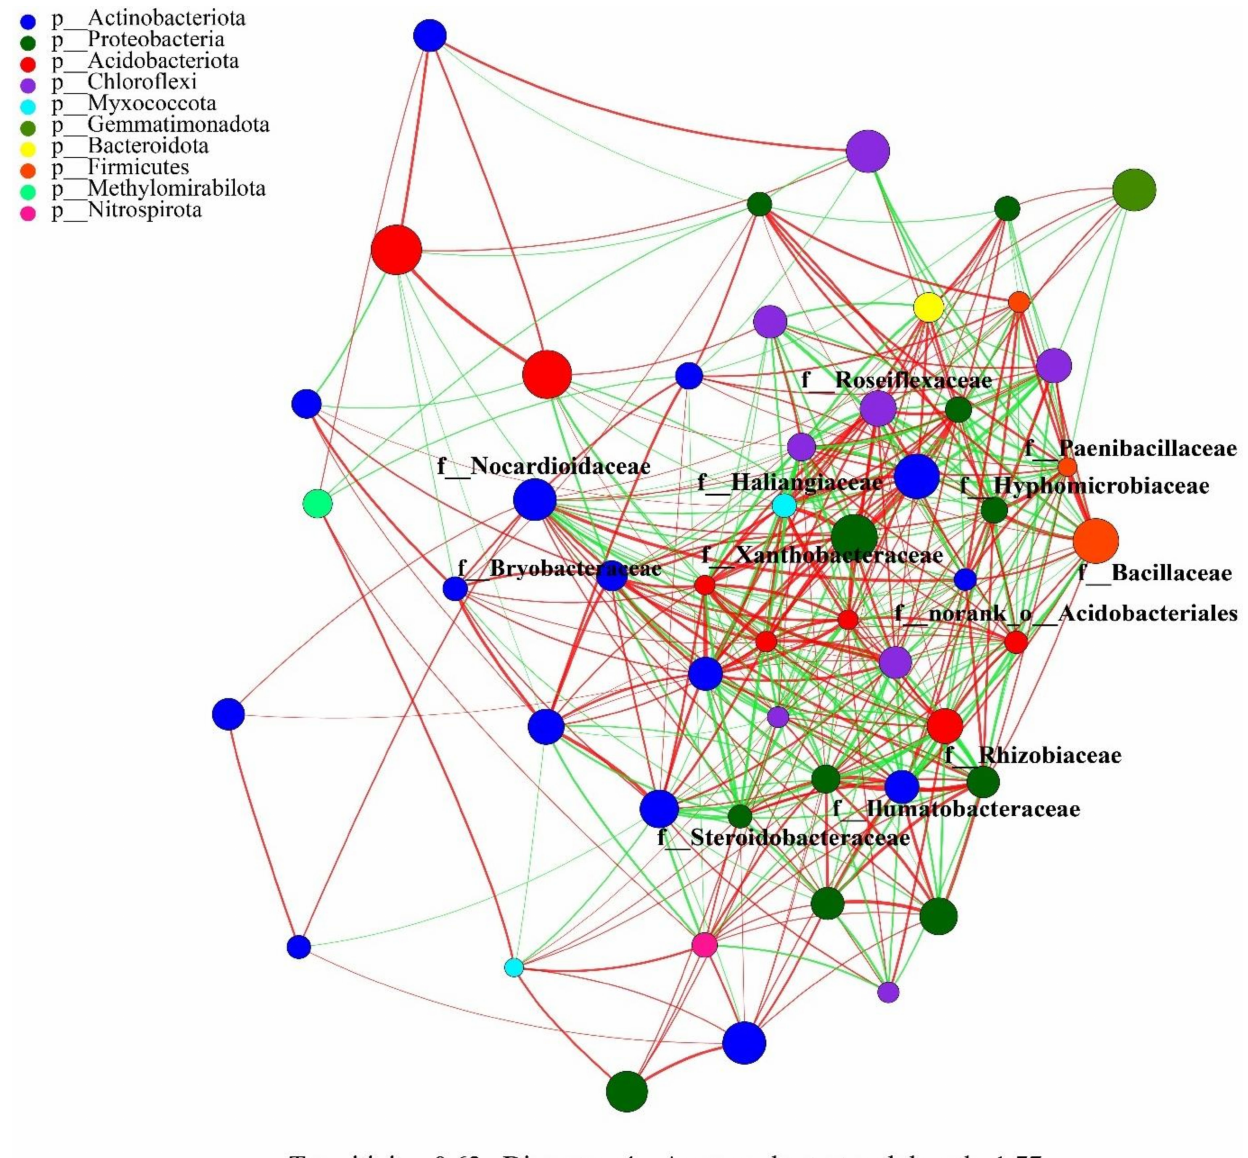
Figure 4. Rhizosphere bacterial ecological network in different soil types of pecan plantations. The network shows the top 50 species in abundance. Node size indicates species abundance, and different colors indicate different species. Red on the line indicates positive correlation and green indicates negative correlation. The thickness of the line indicates the magnitude of the correlation